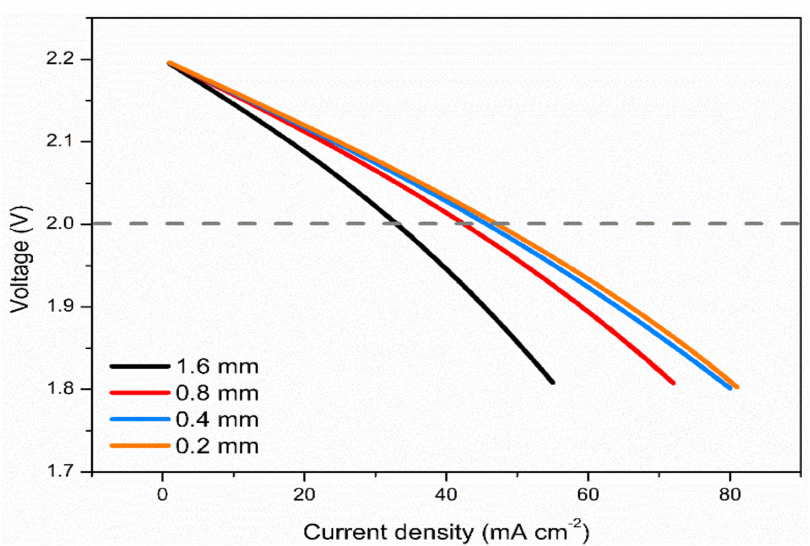
Figure 7. Effect of different electrode thicknesses. Electrolyte: 100 mM V(acac) 3 in 500 mM TEABF 4 ; SOC: 50%; flow rate: 25 mL min − 1 ; temperature: 300